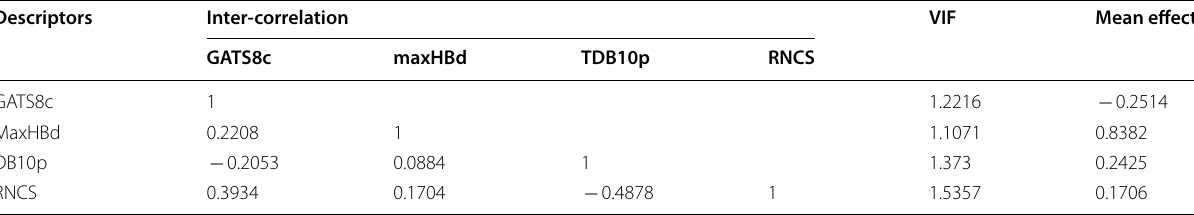
Table 5 Correlation matrix, VIF and mean effect (ME) for the QSAR model